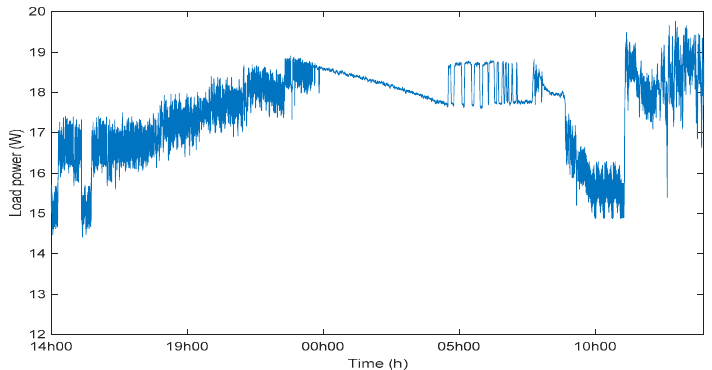
Figure 9. Ventilation system’s daily electricity consumption.